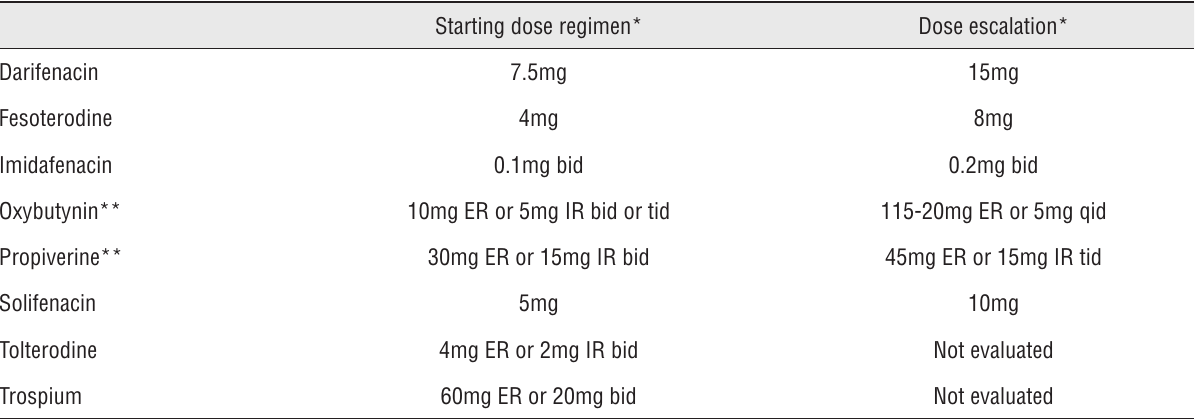
Table 1 - Antimuscarinic agents for adults with